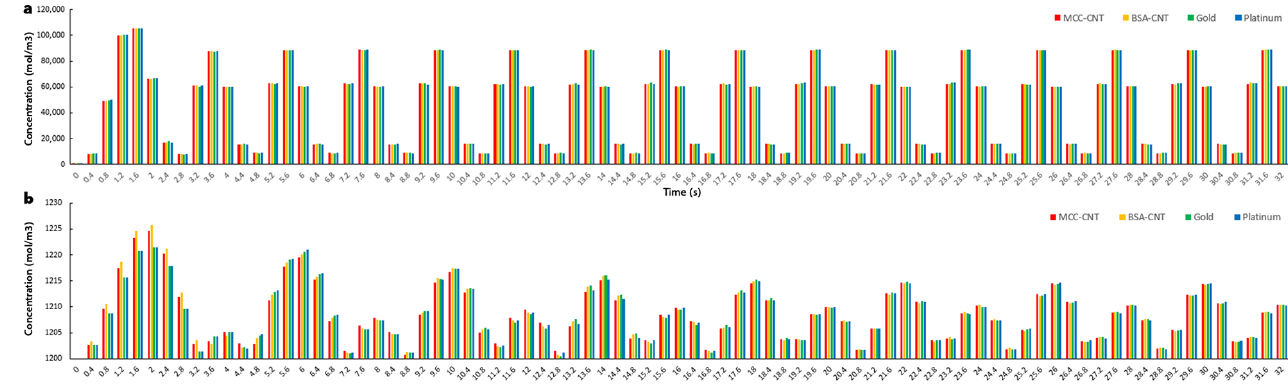
Figure 8. a and b show cation concentrations in different seconds in IPMC with several electrodes in models A and B, respectively.